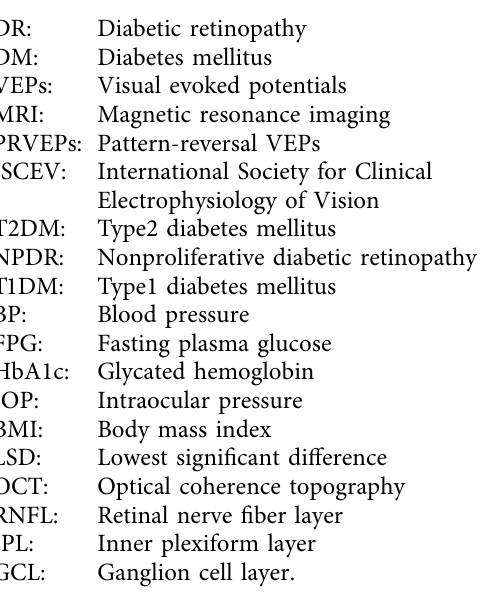
Supplementary Table (1): the parameters of 60 min PRVEP test of right and left eyes of each group (mean ± SD). Supplementary Table (2): the parameters of 15 min PRVEP test of right and left eyes of each group (mean ±